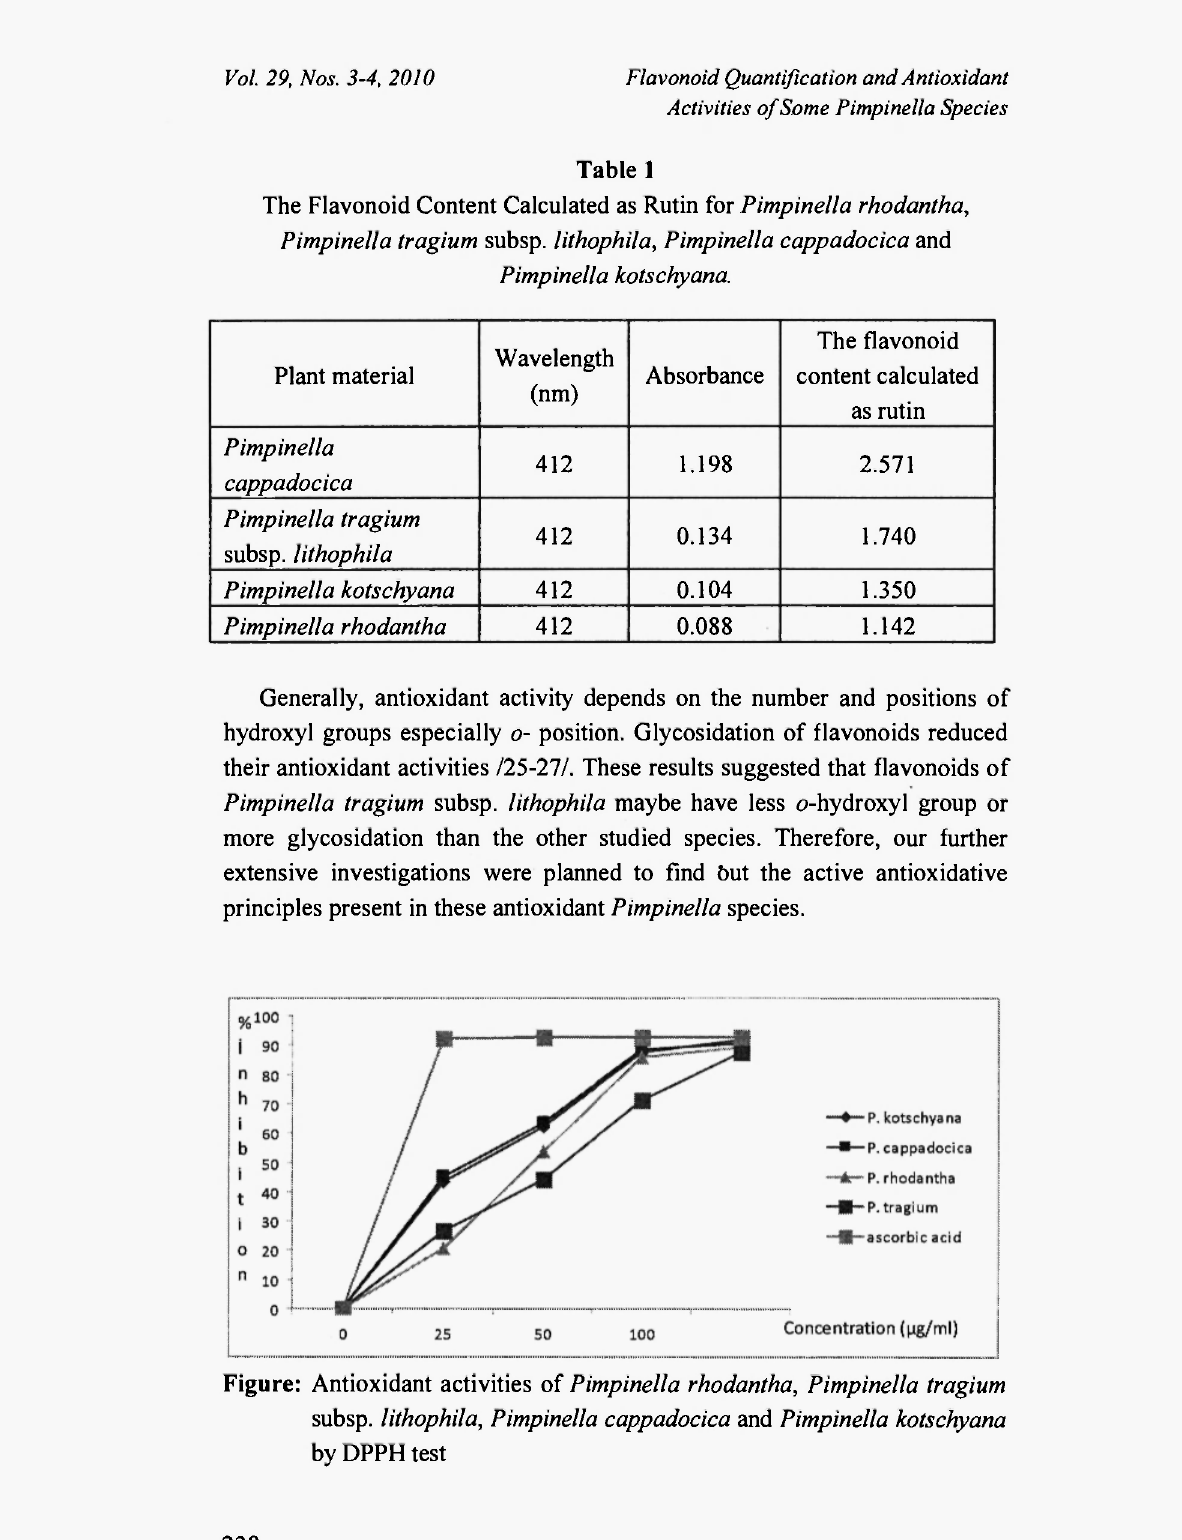
The Flavonoid Content Calculated as Rutin for Pimpinella rhodantha,